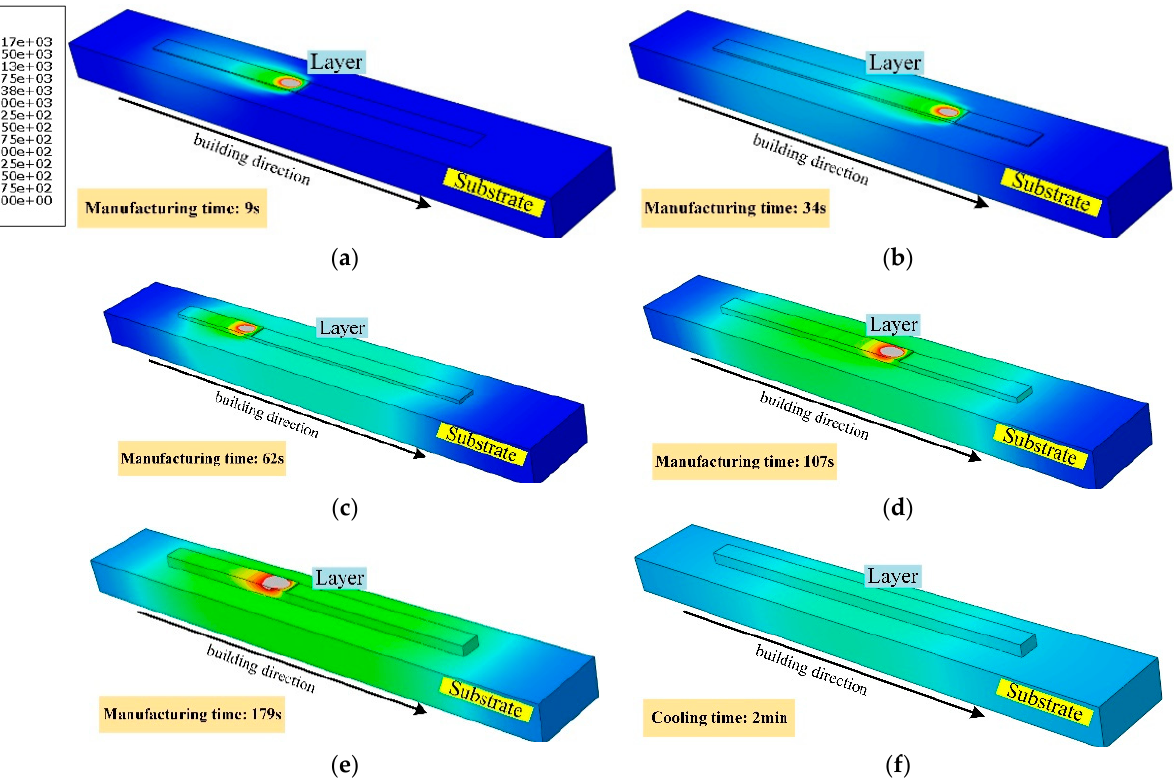
Figure 7. Temperature distributions of the thin-walled sample manufactured by DED AM: ( a ) at 9 s; ( b ) at 34 s; ( c ) at 62 s; ( d ) at 107 s; ( e ) at 179 s; ( f ) after cooling for 2 min.